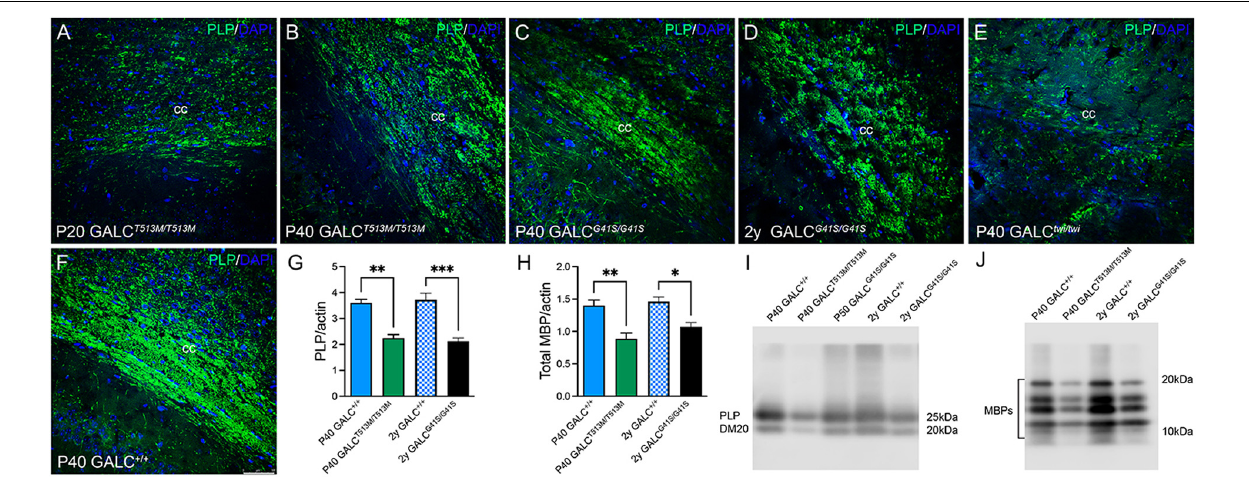
FIGURE 7 | GALC T 513 M / T 513 M and GALC G 41 S / G 41 S mice exhibit signs of early and late central demyelination. Confocal microscopy after immunohistochemistry using anti-PLP detected reductions of PLP (in green) expression in the corpus callosum of GALC T 513 M / T 513 M mice at P20 (A) and P40 (B) , which are comparable to demyelination observed in P40 TWI (E) . In contrast, demyelination (indicated as a reduction of PLP immunofluorescence) was less evident at P40 (C) , and patchy in the 2 year old (D) GALC G 41 S / G 41 S corpus callosum. (F) shows PLP staining in P40 GALC + / + corpus callosum. Blue: DAPI. Bar = 50 mm. (G–J) Semiquantitation of myelin PLP and MBP levels (by western blotting) in whole brain extracts. Data represent the mean + SEM of n = 4–6/group, analyzed by ANOVA/Tukey’s post hoc test ∗ p < 0.05, ∗∗ p < 0.01, ∗∗∗ p <